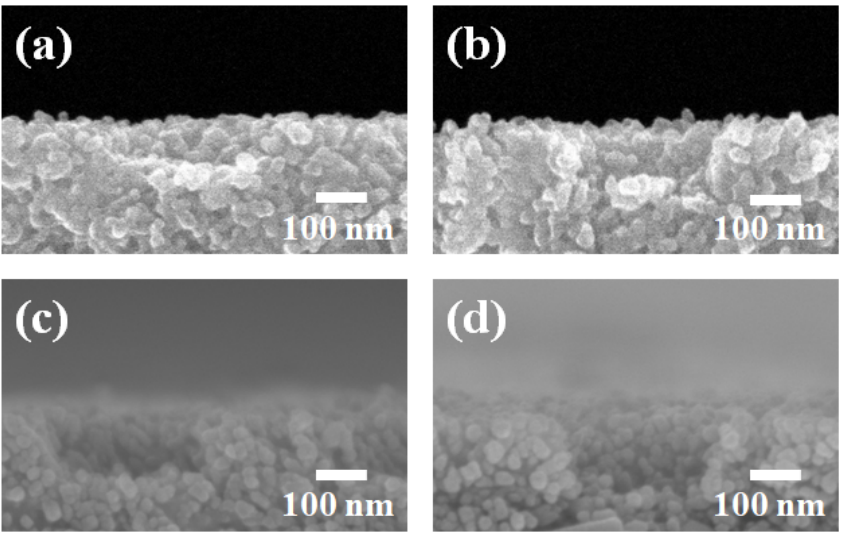
Figure 4. FE-SEM images of nanopatterned mp-TiO 2 thin-film layer. Mp-TiO 2 thin-film layer nanopatterned at the depths of ( a ) 75 nm, ( b ) 97 nm, ( c ) 127 nm, and ( d ) 167 nm.